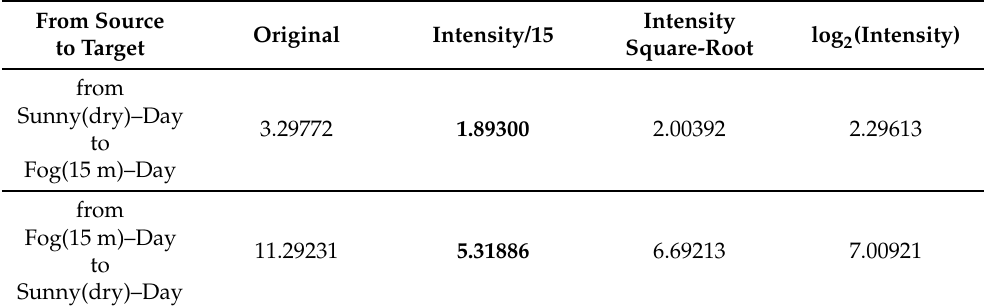
Intensity log (Intensity) 2 Square-Root